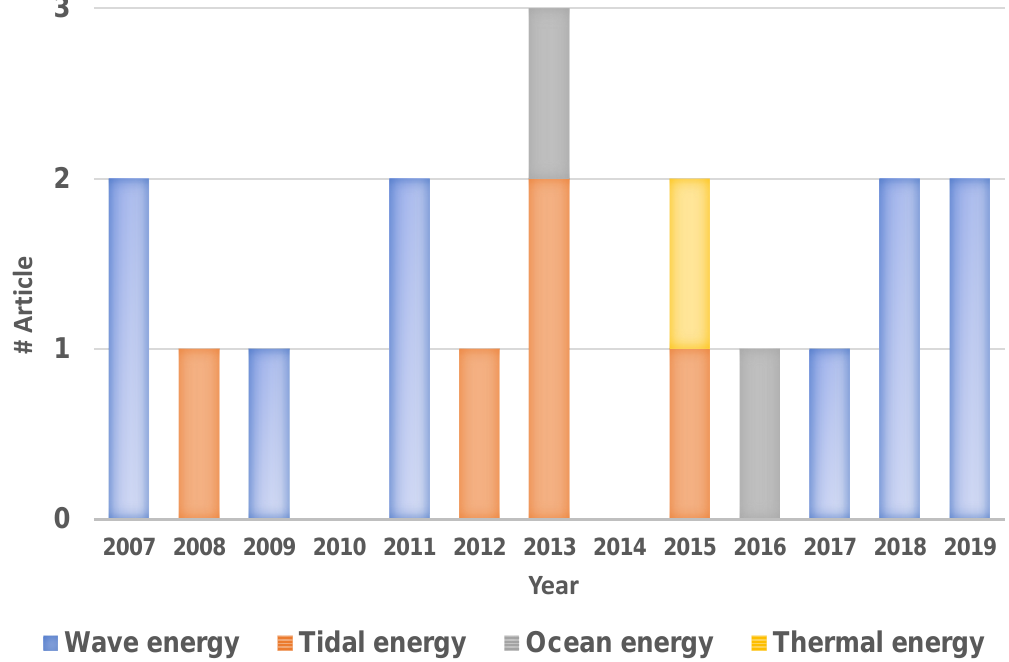
Figure 3. Number of published studies about LCA of ocean energies from 2007 until 2019.